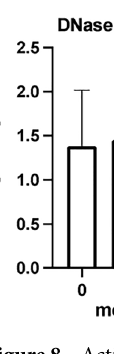
Figure 8. Activity of deoxyribonuclease (DNase) in plasma of rheumatoid patients before the bDMARDs initiation and 3 and 12 months during ongoing treatment ( p < 0.05 = *, p < 0.01 = **, p < 0.001 = ***).